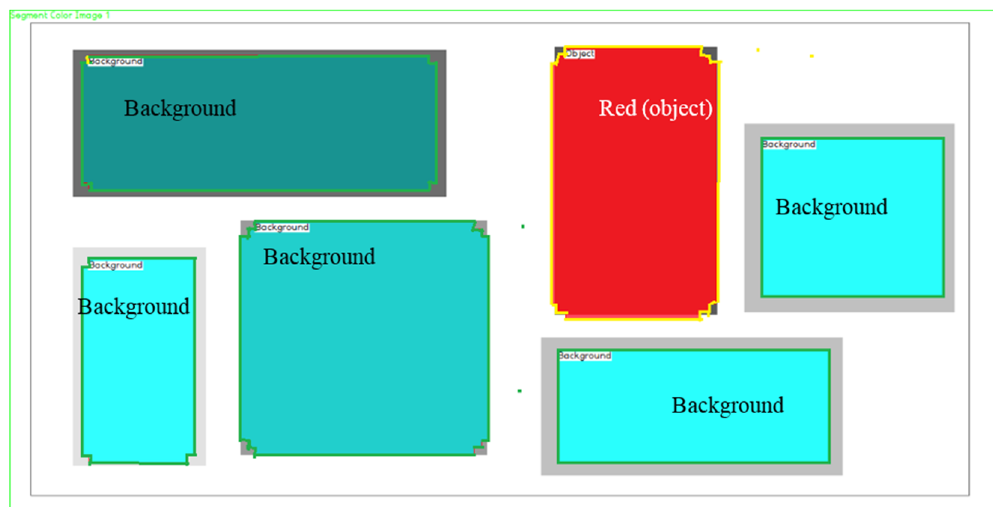
Figure 4. Fuzzy color classifications. Table 2. Object HSL color values.